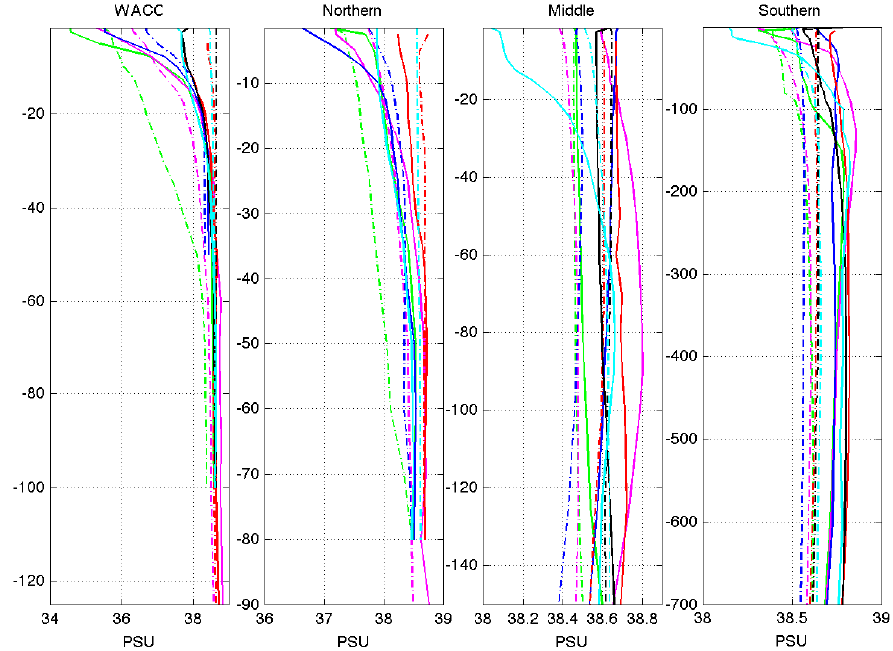
Fig. 10 Salinity Vertical profiles obtained averaging both observations (solid lines) and corresponding model results (dashed lines) spatially and temporally. Colours indicate different cruises listed in Table.1 following Fig.01.